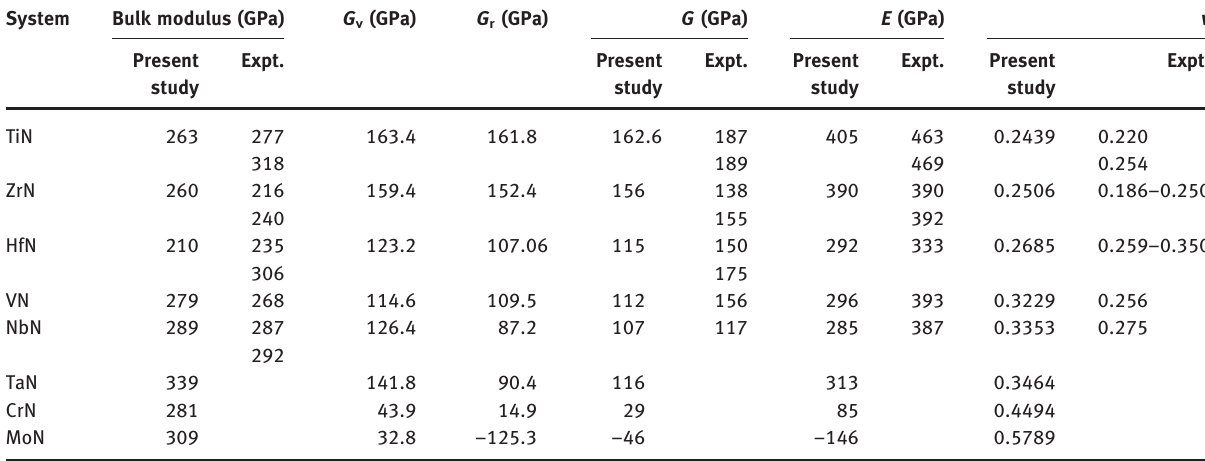
Table 4: Calculated Bulk modulus (B), Shear modulus ( G ), Young ’ s modulus ( E ) and Poisson ’ s ratio ( ν ) of TmNs (Tm ¼ Ti, Zr, Hf, V, Nb, Ta, Cr, Mo) and reported experimental values [35].